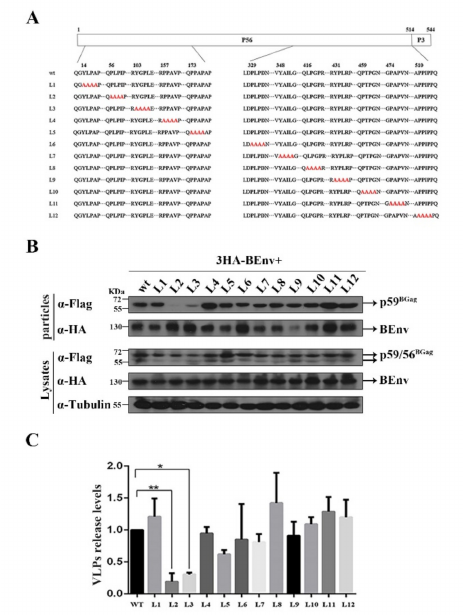
Figure 2. Schematic illustration of the BGag mutants and the impact of each mutant on BFV VLP budding. ( A ) Schematic organization of the BFV Gag protein (BGag) precursor protein and processing products p56 and p3. Below, the sequences of the indicated specific regions of wild-type and mutant BGag proteins are shown. Putative L domain sequence motifs are highlighted in bold, and amino acids altered in the mutant constructs are marked by red letters. ( B ) HEK293T (4 × 10 6 ) cells were transfected with 3HA-BEnv and either the wild-type or domain-mutated (3Flag-BGag L1–L12) vector constructs and harvested at day 2 post-transfection. The cell culture supernatants were filtered through a 0.45 µ m filter and purified by ultracentrifugation. Transfected cells were disrupted using lysis buffer. Levels of proteins in cells and supernatants were measured using Western blotting. ( C ) Quantification of BFV virus-like particle (VLP) budding. Mean values and standard deviation of particle-associated BGag protein corrected for intracellular expression levels ( n = 3) are shown. To quantify the VLPs release levels, the amount of BGag in VLPs was normalized against the amount of intracellular BGag, which were first normalized against the GAPDH loading control. The data are the averages of three independent experiments. Compared with the wild type (wt): * p < 0.05, ** p < 0.01. “ · ” stands for